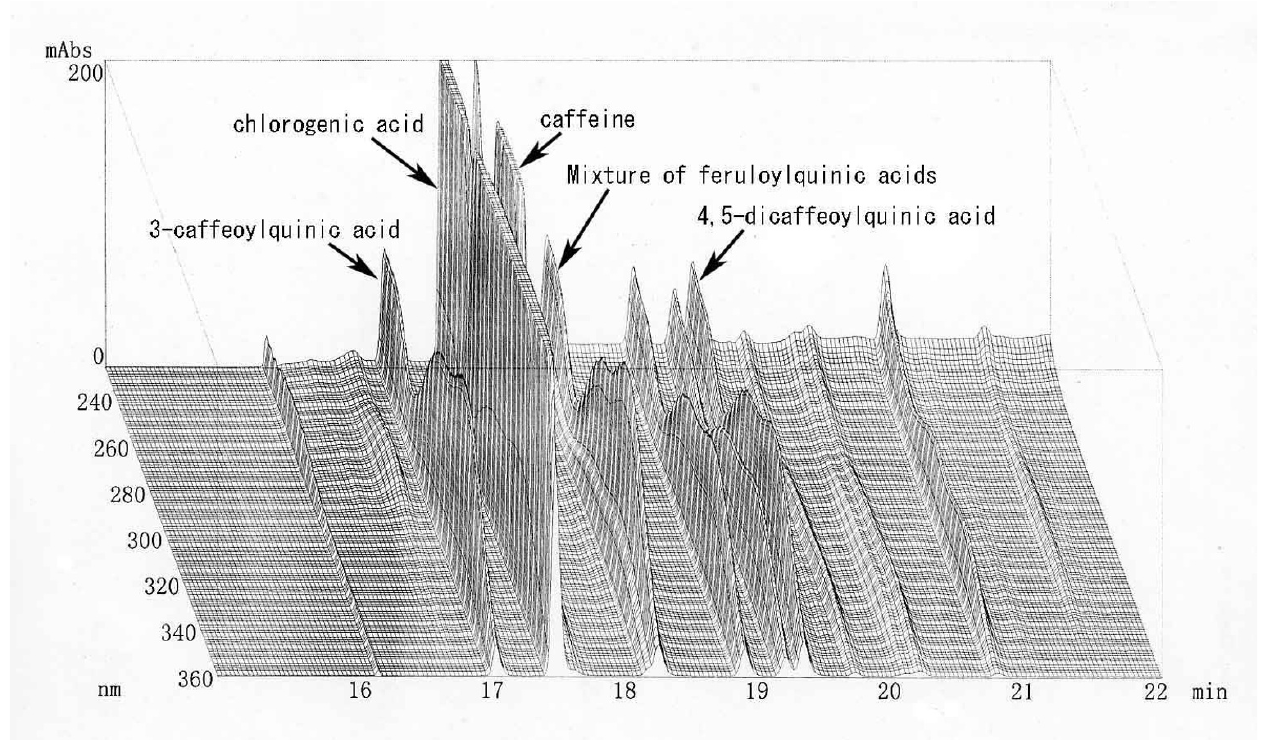
Three dimensional HPLC chromatogram of GCBE Figure 1